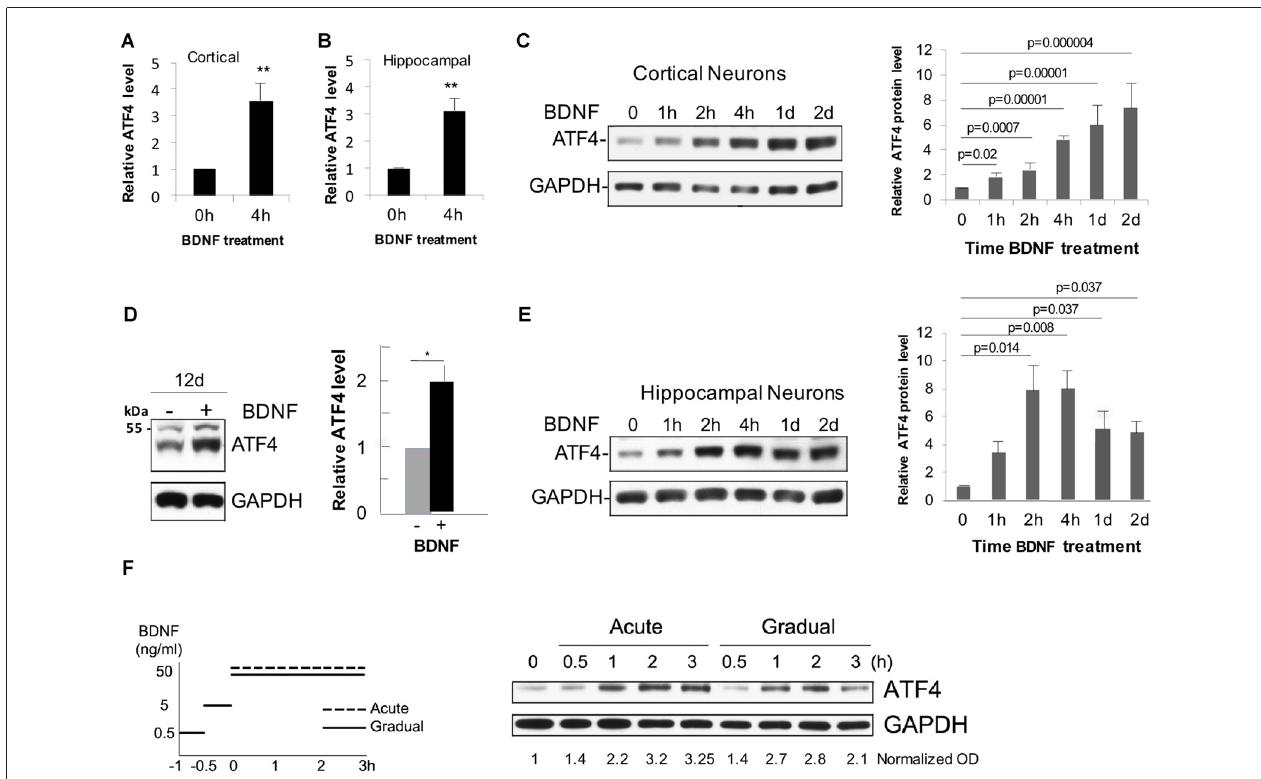
FIGURE 1 | Brain-derived neurotrophic factor (BDNF) promotes rapid and sustained elevation of neuronal activating transcription factor 4 (ATF4) protein expression in primary cultures of rat cortical and hippocampal neurons. (A) Mean elevation of ATF4 protein levels in response to BDNF treatment (4 h, 25 ng/ml) determined by Western immunoblotting in cultures of rat cortical neurons (12 Days in vitro (DIV)). Values (normalized to GAPDH signal for loading control here and in subsequent panels and figures) are relative to levels in non-treated control cultures and represent mean ± SEM from 10 independent experiments, each performed with lysates from 1 to 3 replicate (treated and control) cultures. ∗∗ p = 0.0016 ( t -test). (B) Mean elevation of ATF4 protein levels in response to BDNF treatment (4 h, 25 ng/ml) determined by Western immunoblotting in cultures of rat hippocampal neurons (12 DIV). Values are normalized to levels in non-treated control cultures and represent mean ± SEM from 20 independent experiments, each performed with lysates from 1 to 3 replicate (treated and control) cultures. ∗∗ p = 0.0006 ( t -test). (C) Time course of BDNF-stimulated (25 ng/ml) increases in ATF4 protein in cultured (12 DIV) cortical neurons as determined by Western immunoblotting. Left-hand panel shows representative immunoblot, right-hand panel shows quantification from 3 to 4 independent experiments, each with one sample per time point. Values are normalized to levels in non-treated control cultures and represent mean ± SEM. p values were calculated vs. 0 time using the Kruskal-Wallis test (overall p = 0.003) with the post hoc Conover method adjusted by the false-discovery rate (FDR) procedure of Benjamini-Hochberg. (D) BDNF sustains elevation of ATF4 protein levels in cultured cortical neurons. Cultures were maintained for 10 days without BDNF and then for an additional 12 days ± BDNF (25 ng/ml) and then harvested for ATF4 expression by Western immunoblotting. Left panel shows representative immunoblot, right panel quantification from three independent experiments, each with one sample per time point. ∗ p value ( p = 0.013) calculated by t -test. The band at the 55 kDa marker on the blot is non-specific (Liu et al., 2014). (E) Time course of BDNF-stimulated (25 ng/ml) increases in ATF4 protein in cultured (12 DIV) hippocampal neurons as determined by Western immunoblotting. Left-hand panel shows representative immunoblot, right-hand panel shows quantification from 3 to 4 independent experiments, each with one sample per time point. Values are normalized to levels in non-treated control cultures and represent mean ± SEM. p values were calculated vs. 0 time using the Kruskal-Wallis test (overall p = 0.028) with the post hoc Conover method adjusted by the FDR procedure of Benjamini-Hochberg. (F) BDNF elevates ATF4 protein in cultured hippocampal neurons (12 DIV) for both acute and gradual treatment protocols. Left panel illustrates treatment protocols (Ji et al., 2010), right panel shows Western immunoblot of response. Normalized (to GAPDH) optical density values are given below the blot. Data represent a single experiment. Comparable results were obtained in an independent experiment with cortical